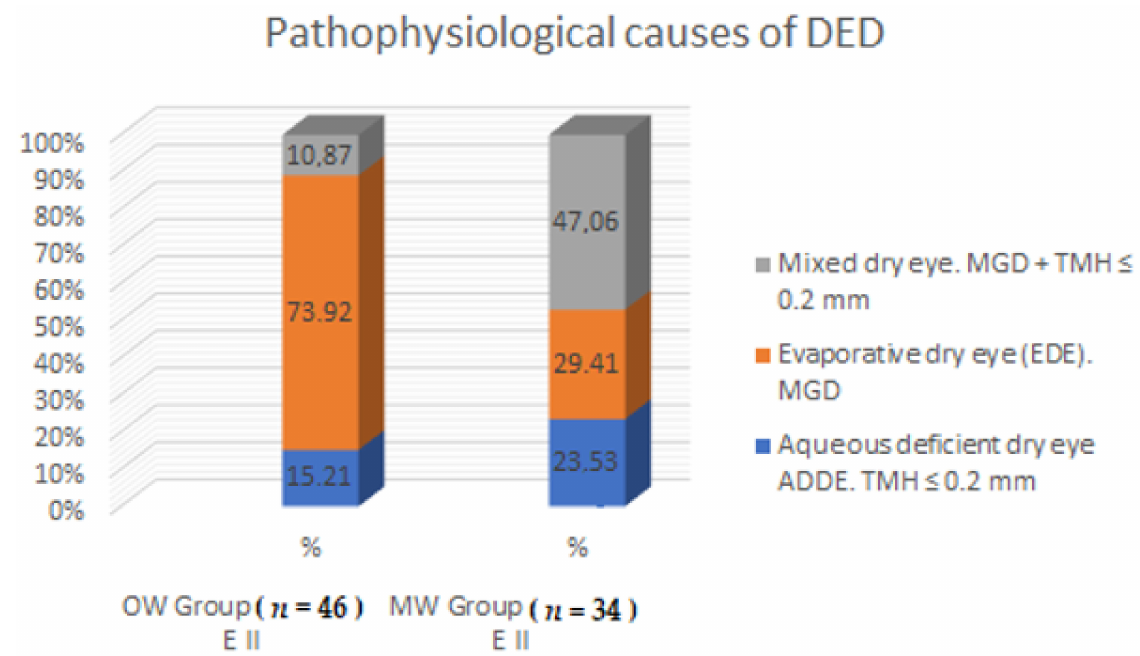
Figure 8. Pathophysiological causes of dry eye disease in the OW and MW groups at the 1-year